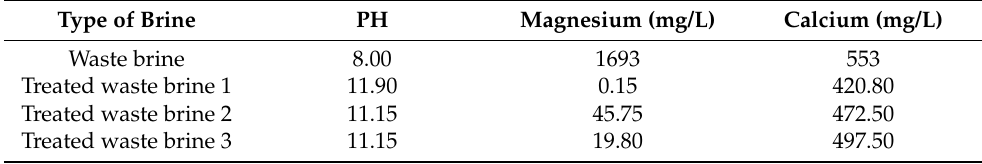
Table 2. Calcium and magnesium ion concentrations before and after waste brine